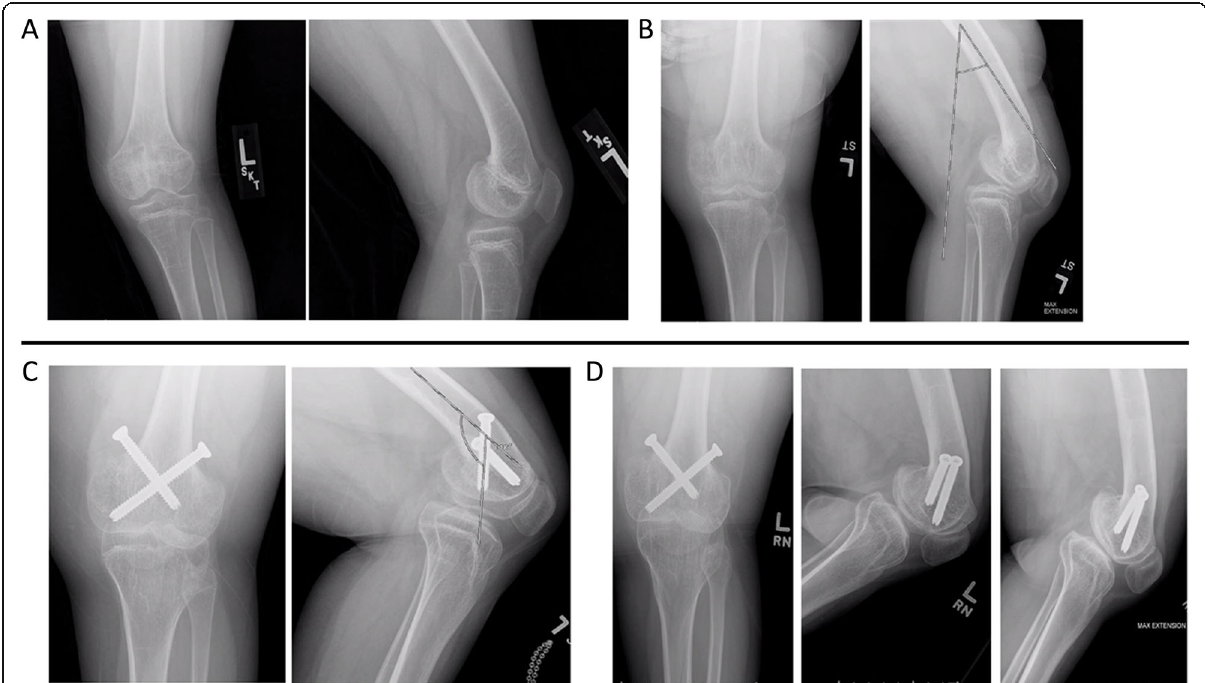
Fig. 3 a: Left knee films, 2years 9months. b: Left knee films, 10years 5months/ c: Left knee films, 11years 7months. d: Left knee films, 13years